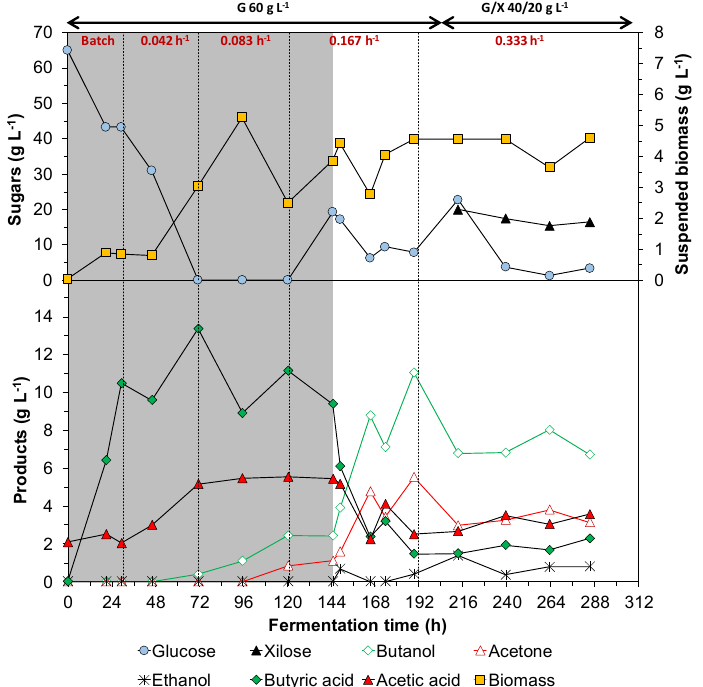
Figure 5. Fermentation profile of C. acetobutylicum with plastic rings at different dilution rates (h − 1 ) and monosaccharide feed. Grey area shows acidogenic phase (pH ≥ 6.0) while unshaded area is solventogenic phase (pH ≥ 4.8). G denotes glucose and X xylose.